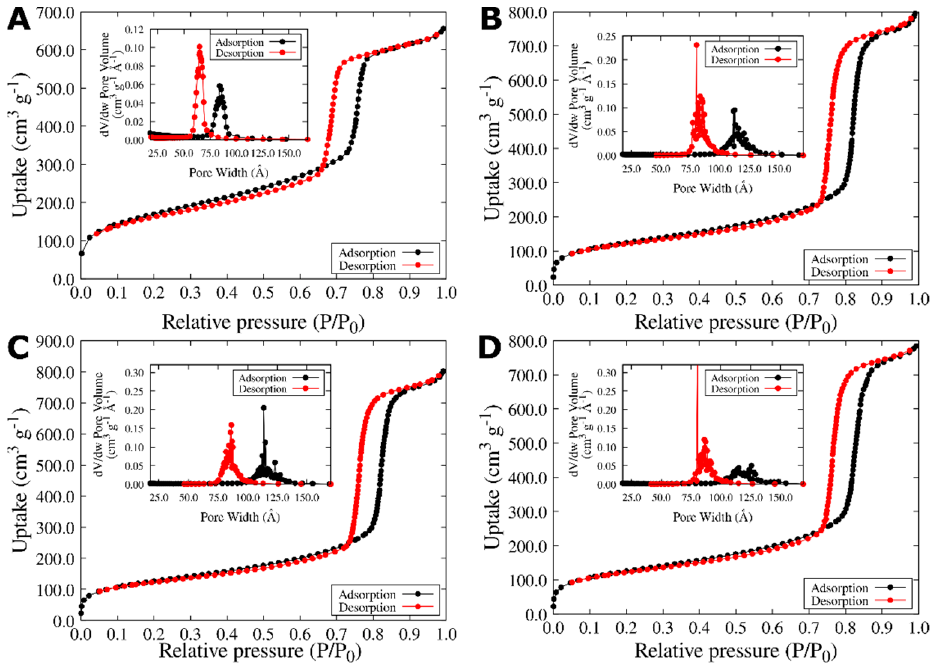
Figure 4. Experimental N 2 adsorption/desorption isotherms of ( A ) SBA − 15, ( B ) NQ@SBA − 15, ( C ) 2NQ@SBA − 15, and ( D ) 5NQ@SBA − 15.